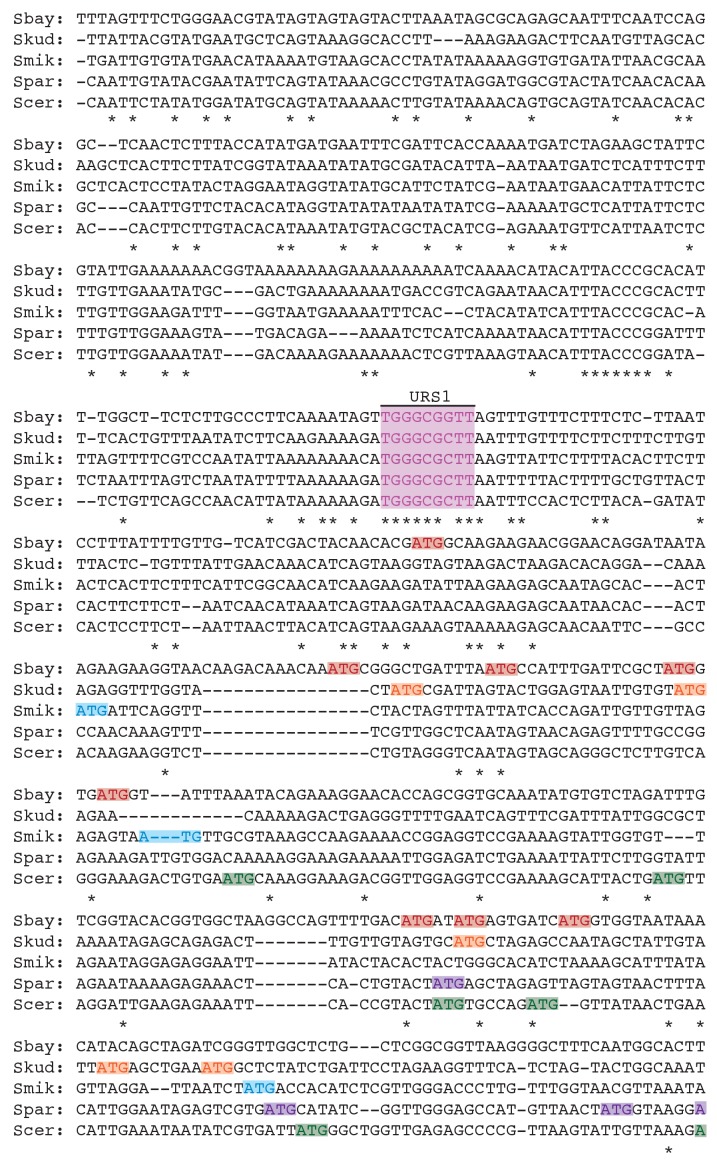
Clustal analysis for the upstream intergenic region of the NDC80 locus across five Saccharomyces species.* indicates sequence identity; - indicates a skipped base pair. The displayed sequences are on the same strand as the NDC80 ORF sense strand, in 5’ to 3’ direction (from left to right). Figure 9—figure supplement 2 is a continuation of supplement 1. Putative Ume6 (URS1) and Ndt80 (MSE) binding sites are marked as pink and blue regions, respectively. Colored boxes (one color for each species) denote the putative upstream ATGs that locate at least 50 bp downstream of the URS1 site and up to the start of the NDC80 ORF. The number of putative AUG uORFs for each species is summarized in the table in Figure 9—figure supplement 2.